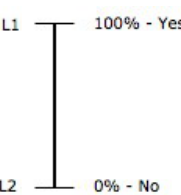
Figure 2. Level descriptor of a subcriterion with two levels